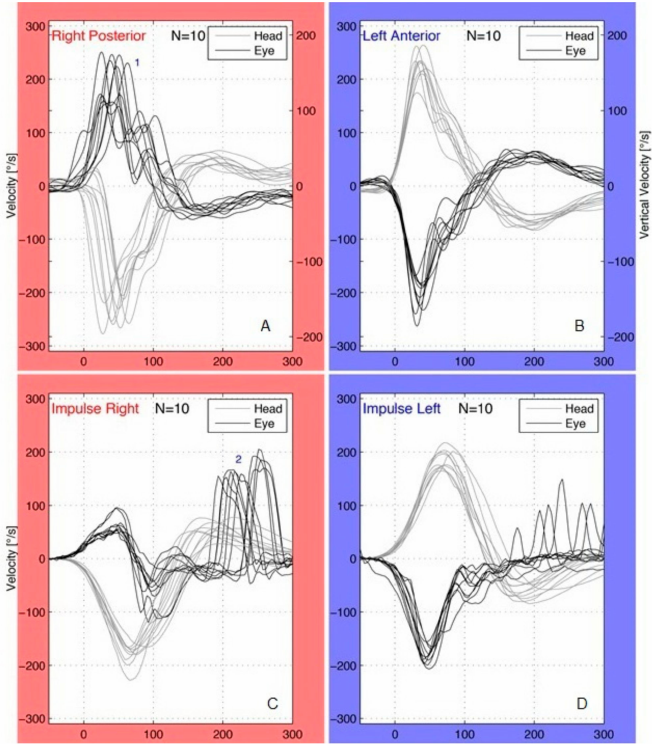
Figure 2. Patient with right acute vestibular neuritis ( A , B ) and affected posterior canal (PC) plane: pathological covert saccades (1) were present in the right PC ( A ). Covert saccades occurred during the head impulses and their peak velocity was more than 100 ◦ /s; no saccades were observed in the left unaffected anterior canal ( B ). Patient with right acute vestibular neuritis ( C , D ) and affected horizontal canal (HC) plane: pathological overt saccades (2) were present in the right HC ( C ) following the end of the head movements; the saccades found in the left HC ( D ) were not pathological (peak velocity <100 ◦ /s, repeatability <50% of total